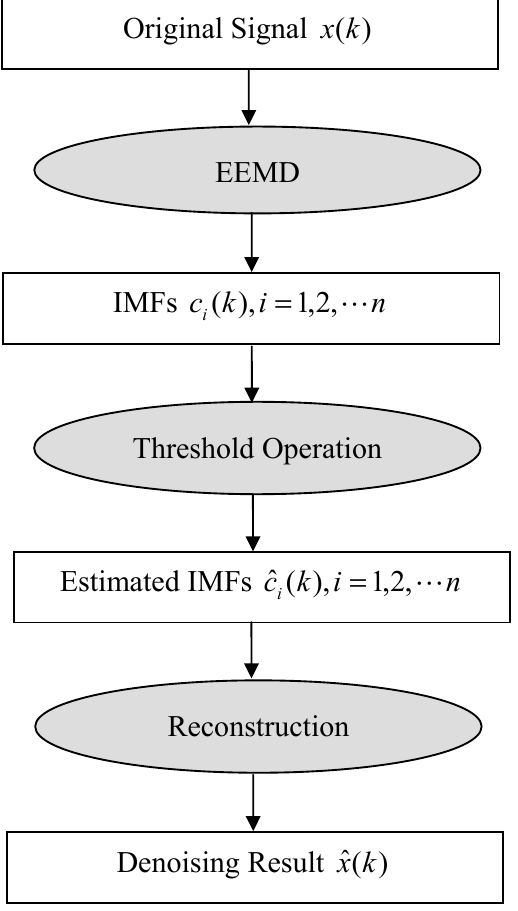
Figure 2. The operation procedures of the proposed denoising